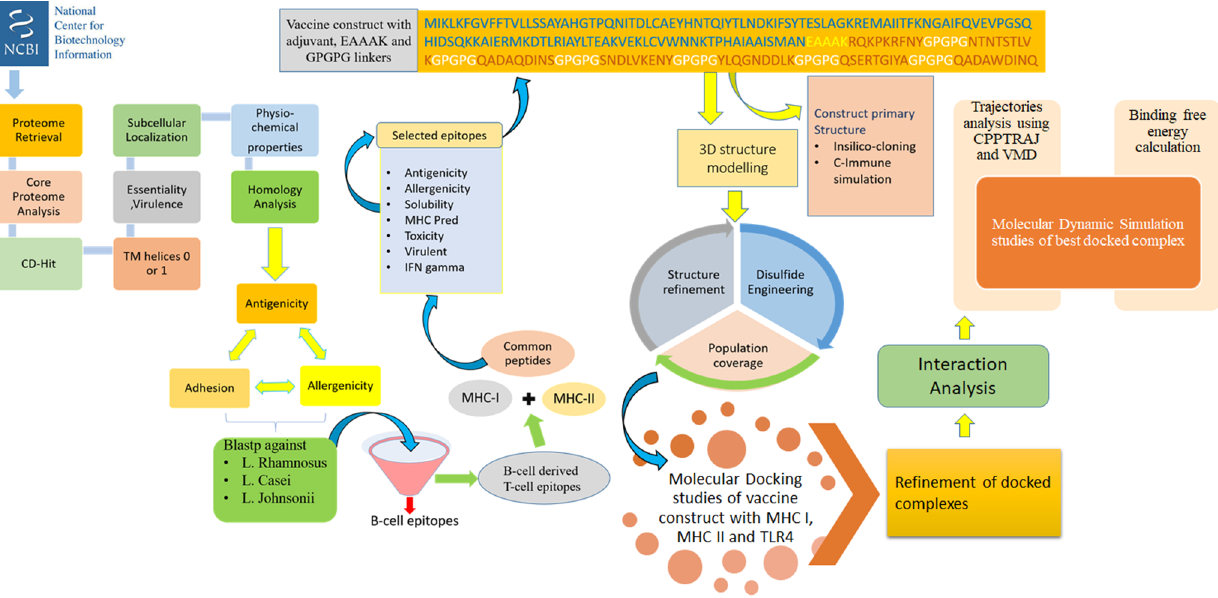
Figure 1. Complete flow of work done to prioritize potential vaccine candidates from pan-proteome of Klebsiella species.